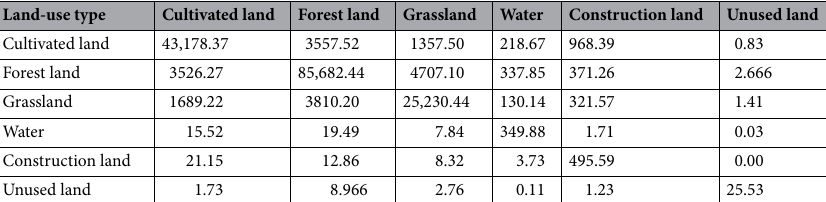
Table 6. Land-use change transfer matrix of Guizhou Province (km 2 ) over the 1980–2018 period.